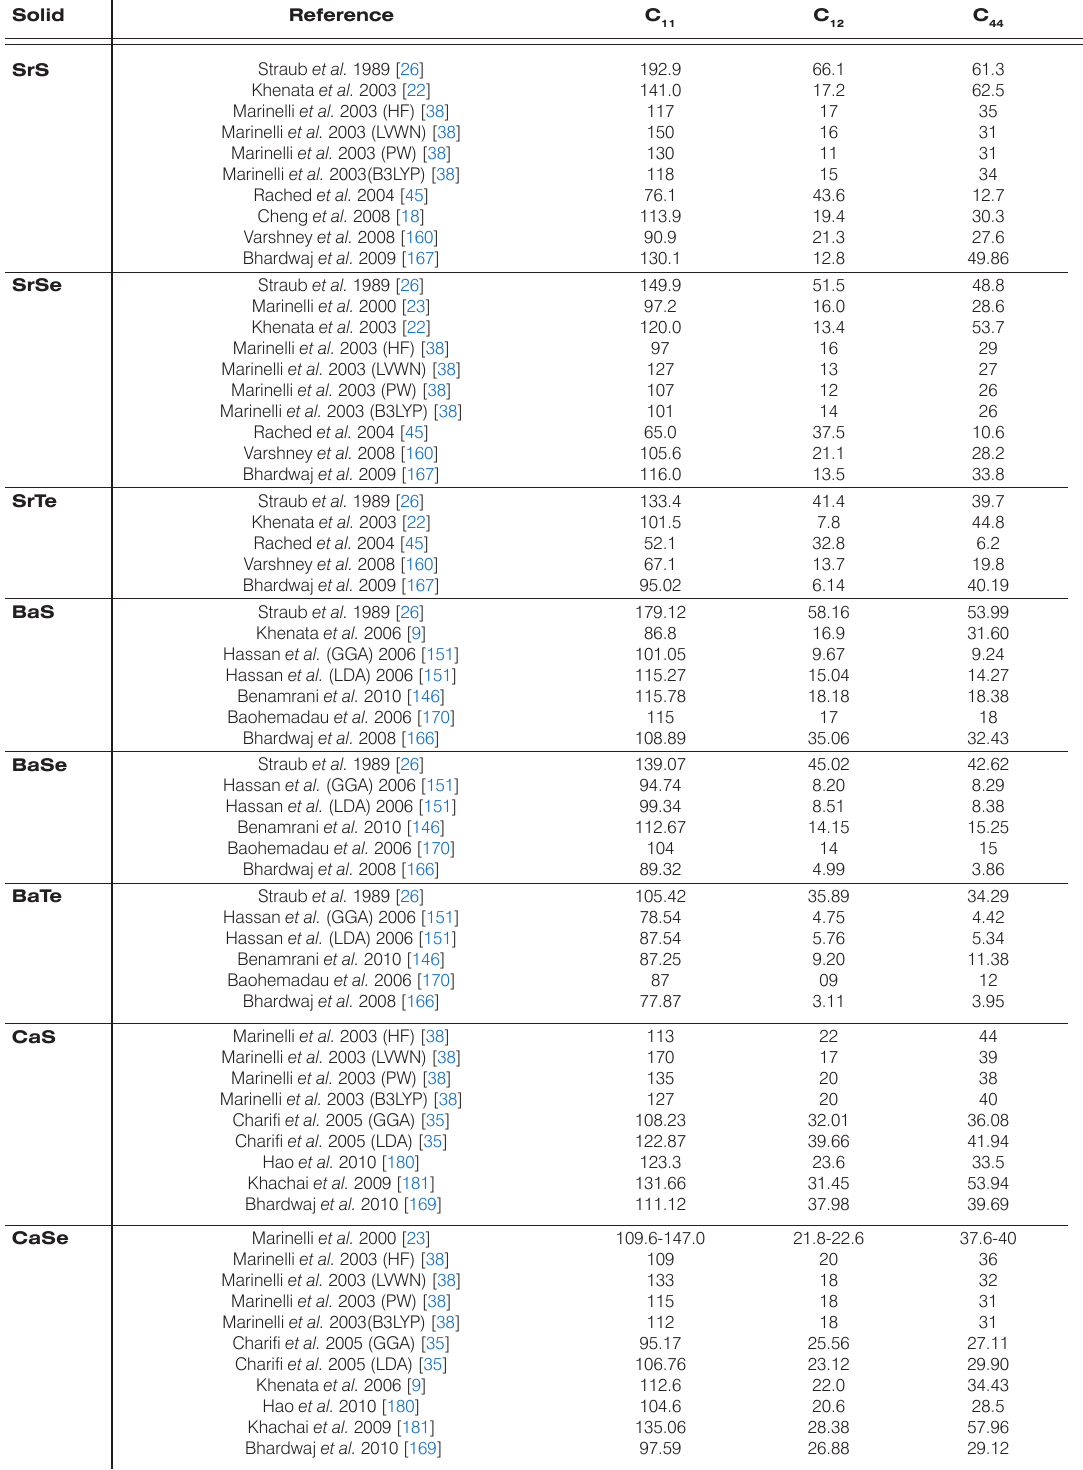
Table 3. Elastic constants and bulk modulus for B1